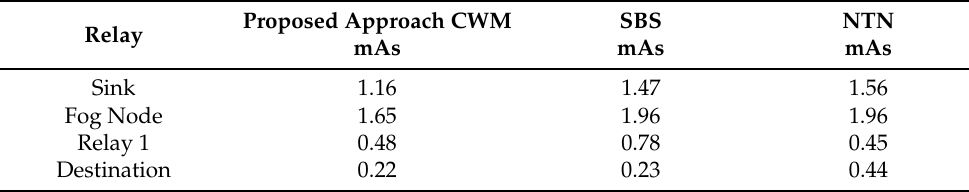
Figure 14. Measured time of every single node in active mode using 2 Relays. Table 2. Single nodes energy consumption using 1